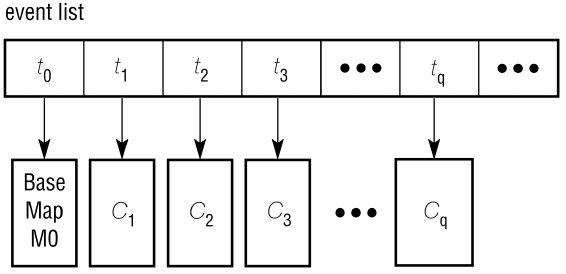
Figure 6. Representation of change organized as a function of time in the temporal geographic information system (TEMPEST) prototype (from [113] ).